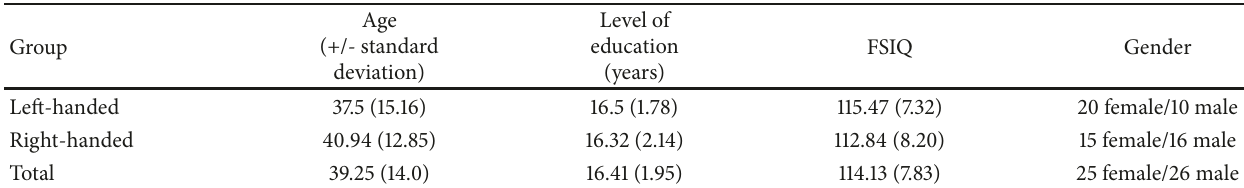
Figure 3: ROIs used to determine hemispheric language laterality. Yellow, orange, and red ROIs were used to calculate active voxels for left- hemisphere language dominance; blue, light blue, and light green ROIs were used to calculate active voxels for right-hemisphere language dominance. Table 1: Descriptive statistics of study participants.